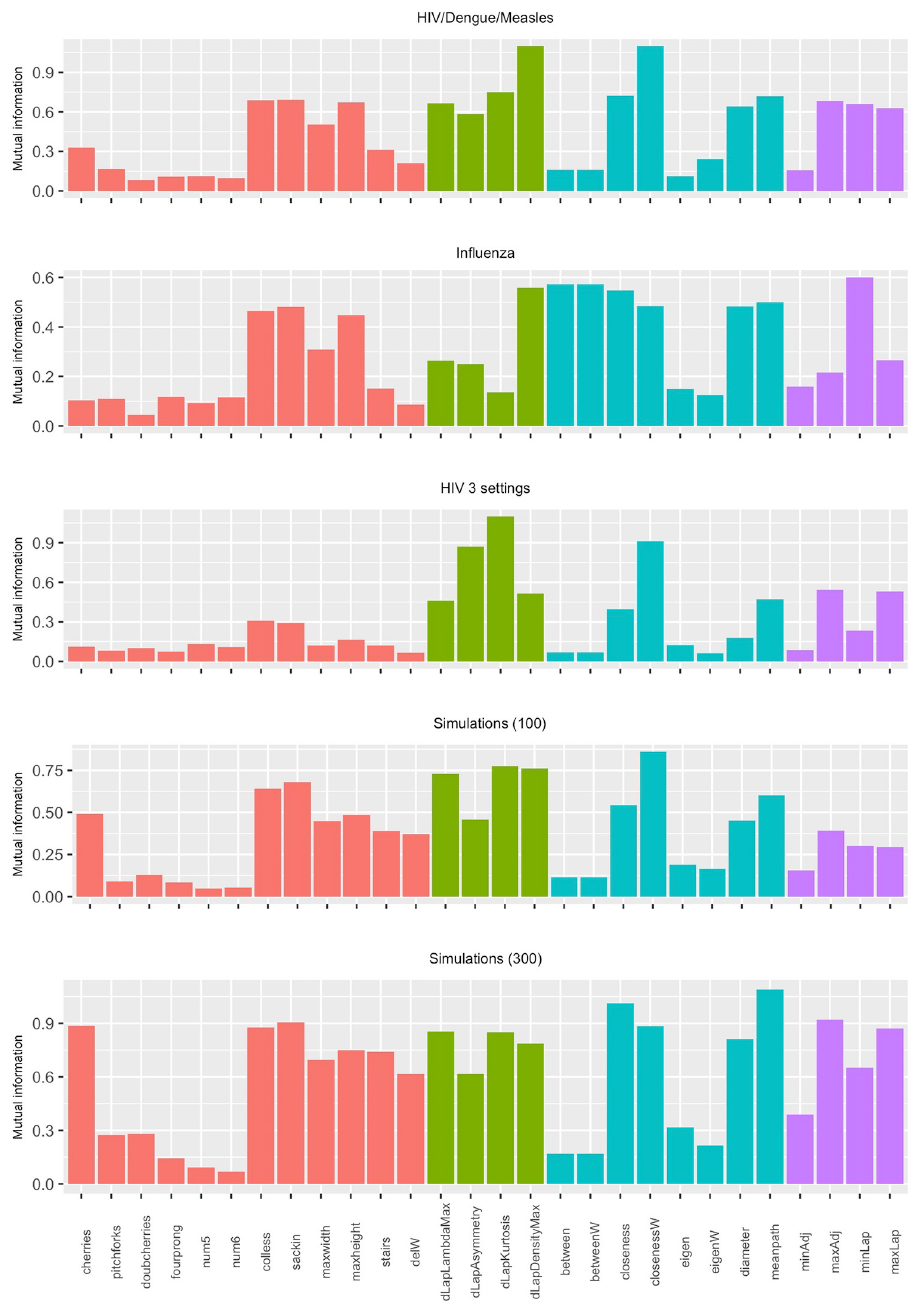
Fig 5. Mutual information between tree summaries and the virus type or epidemiological scenario. Labels are as in Table 1, and the colour indicates the type of statistic as per Table 1, i.e. red: basic statistics; green: distance Laplacian spectrum statistics; blue: network science-based statistics; purple: spectral